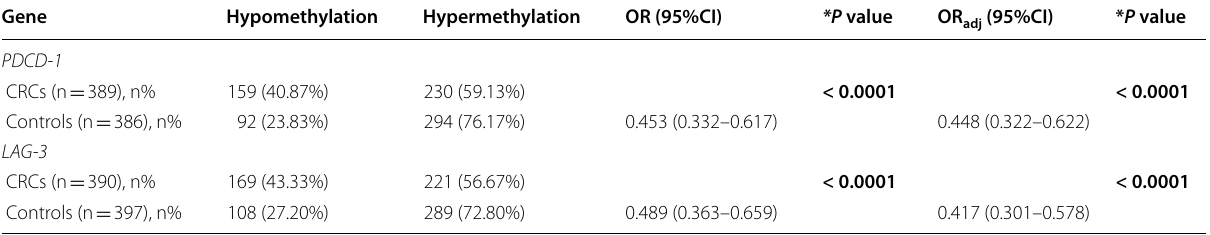
* P values < 0.05 were considered statistically significant and were indicated in bold CRC, colorectal cancer; CI, confidence interval; OR, odds ratio; OR adj : adjusted for age,